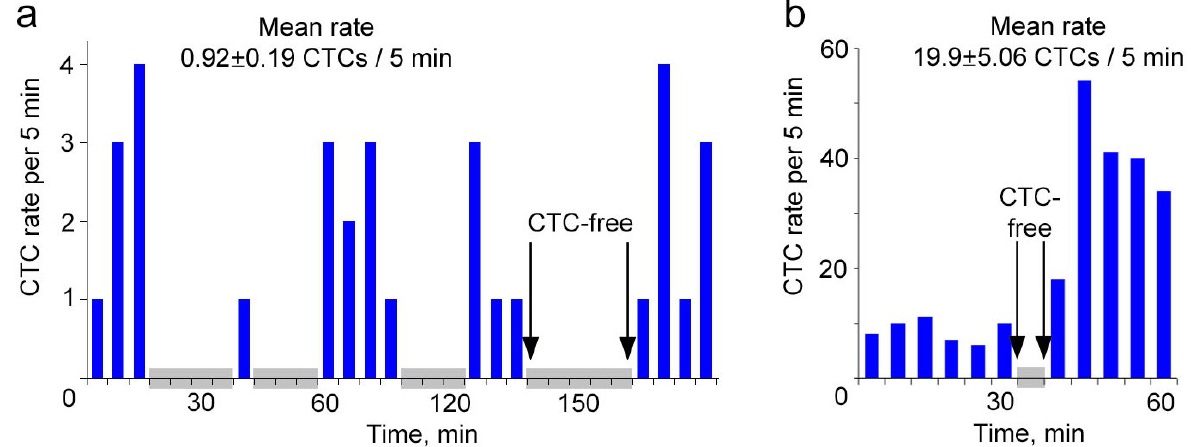
Figure 3. Real-time monitoring of spontaneous CTCs in ear blood vessels of tumor-bearing mice. ( a , b ) CTC dynamics during continuous FFC without averaging in mice at week 2 ( a ) and 5 ( b ) post inoculation. Grey squares show time-intervals of CTCs absence in a detection